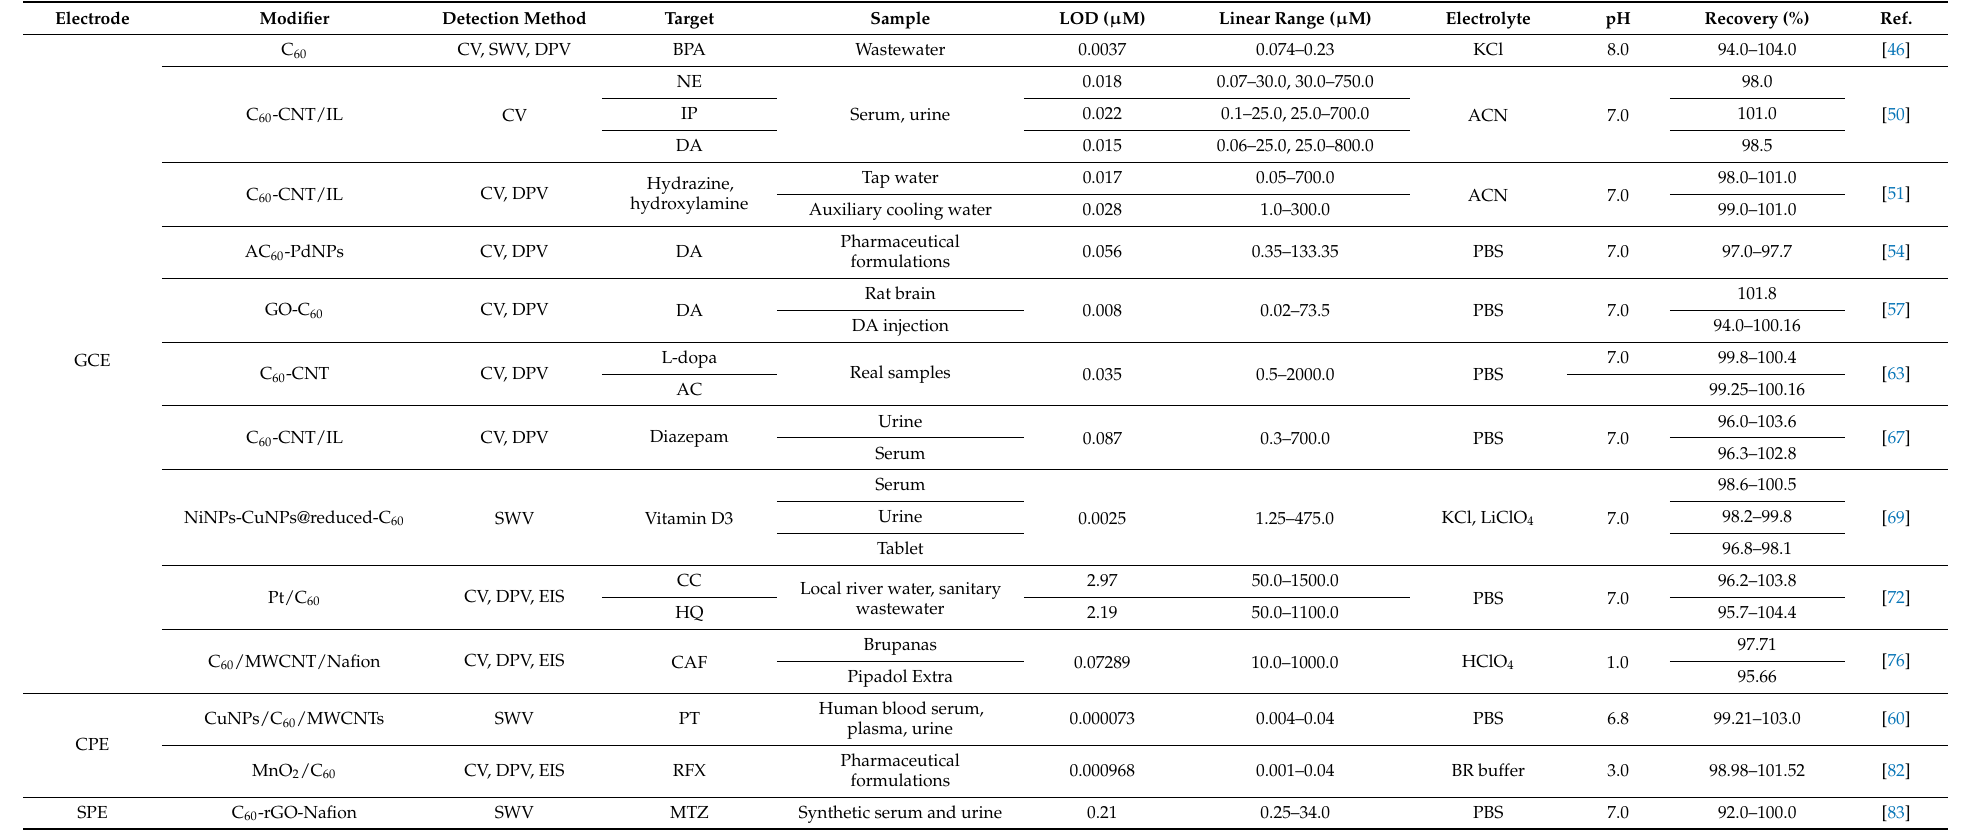
Table 2. Summary of fullerene utilization for pharmaceutical electrochemical sensor